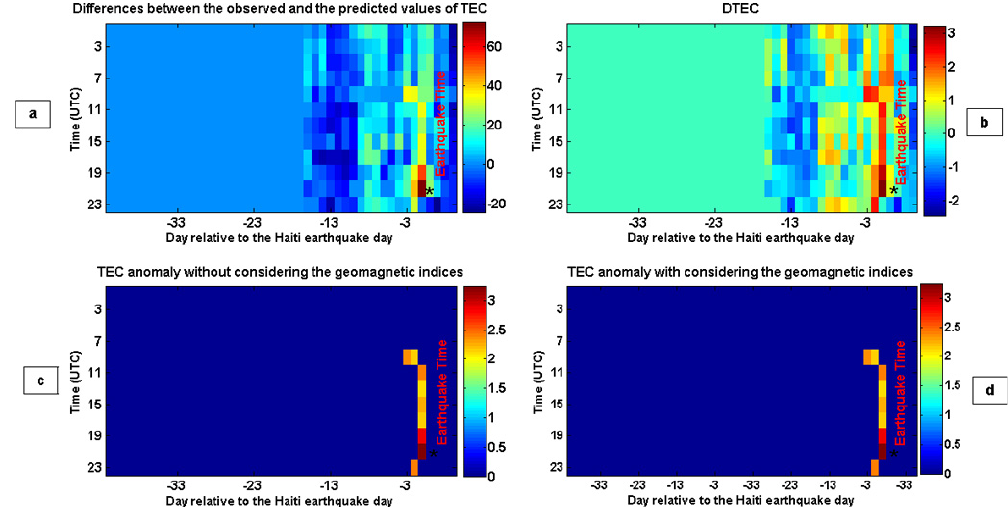
Fig. 8. (a) Differences between the observed and the predicted values of TEC. (b) DTEC variations. (c) Detected anomalies without consid- ering the geomagnetic indices. (d) Detected anomalies with considering the geomagnetic indices.